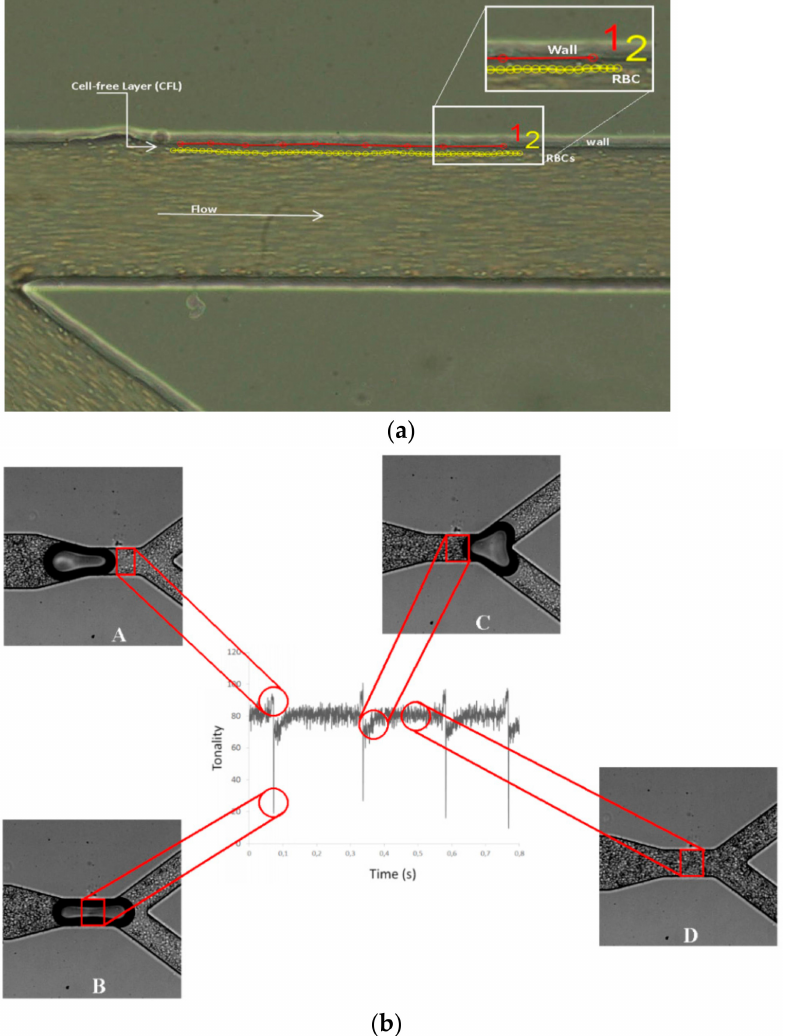
Figure 1. ImageJ plugins: ( a ) MtrackJ used to obtain the RBC trajectory [79] and ( b ) application of the plot Z-axis profile function at the selected ROI